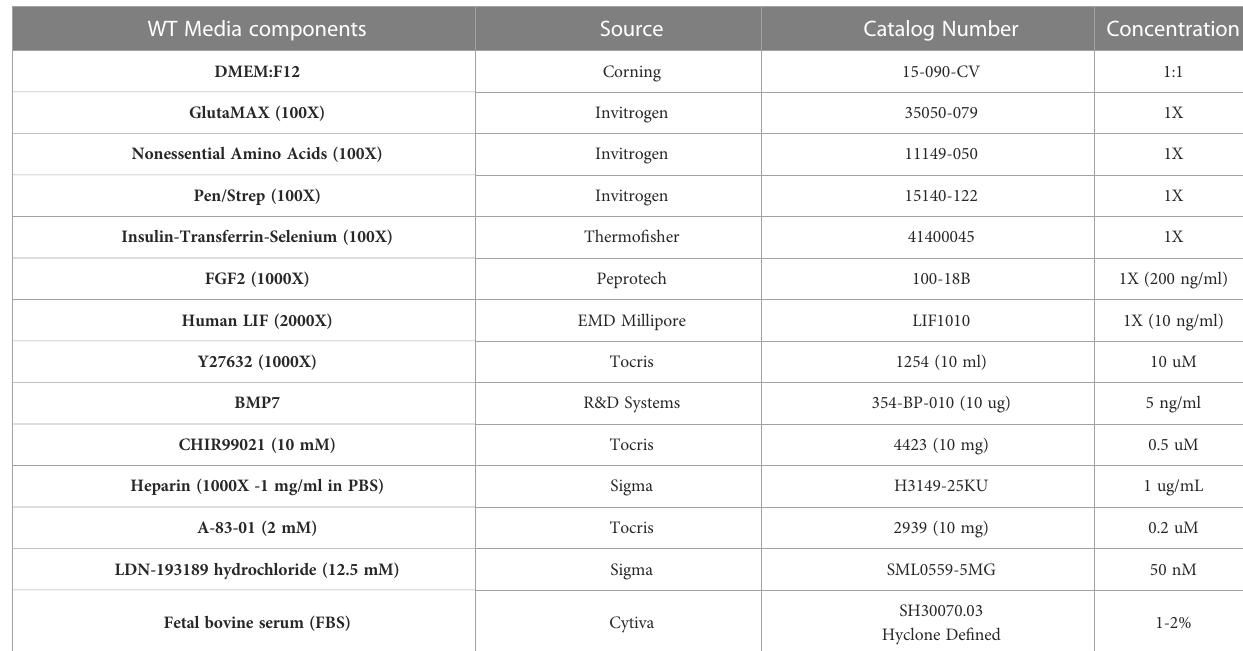
TABLE 1 Medium composition and reagent